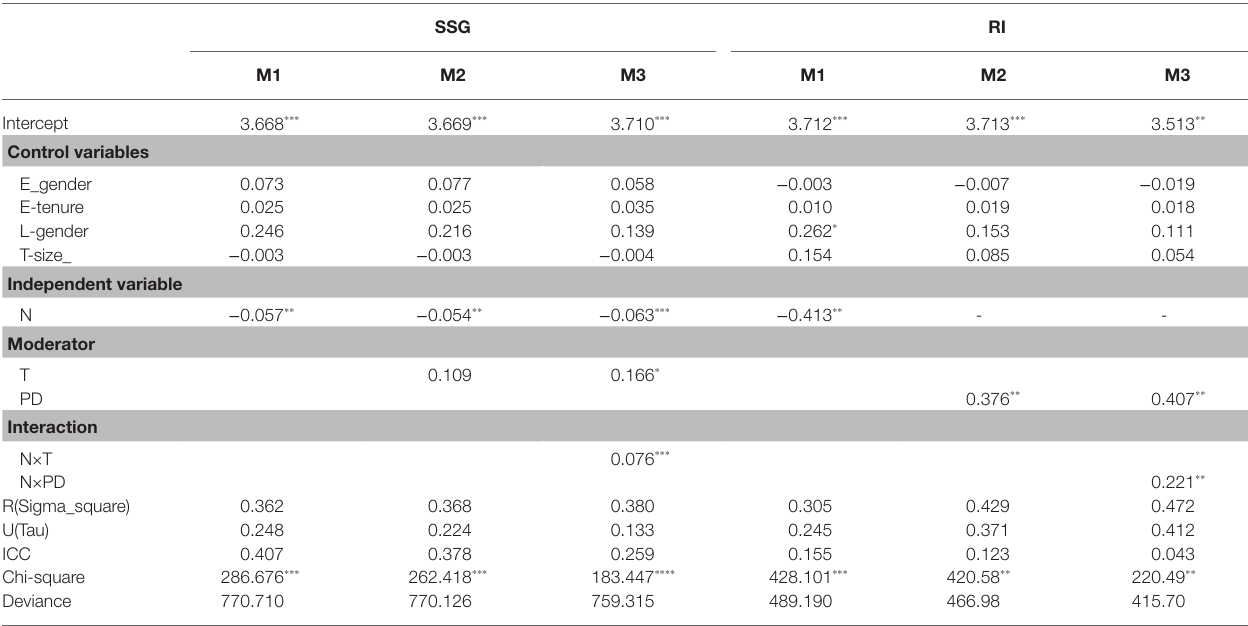
TABLE 6 | Results of moderating regression